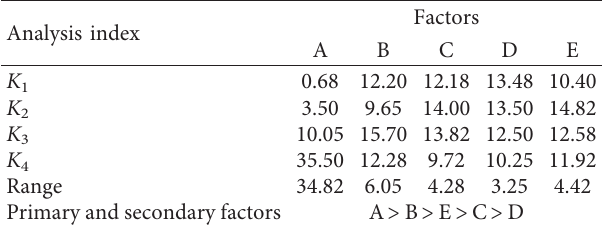
Table 9: Range analysis of slurry water separation rate.